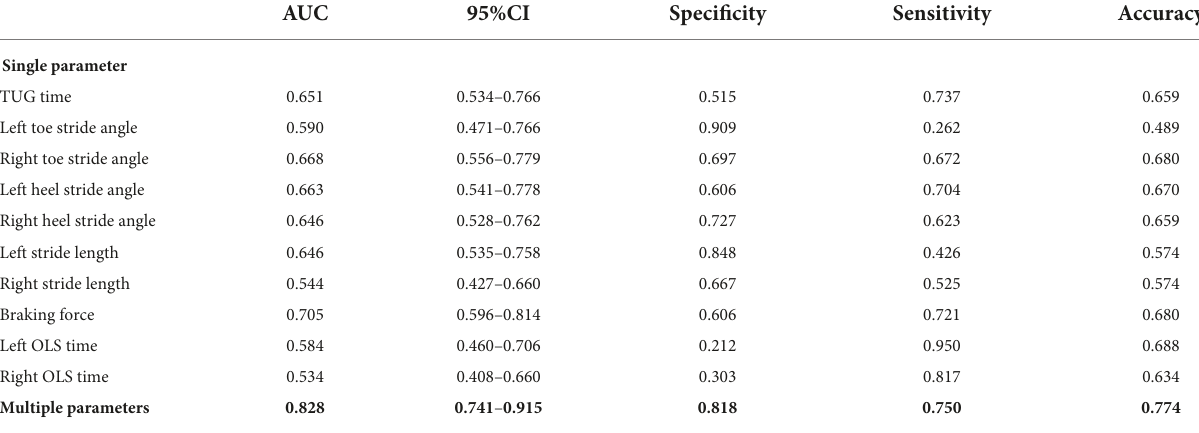
TABLE 3 Diagnostic ability of single/multiple kinematic parameters in amnestic mild cognitive impairment (aMCI). AUC